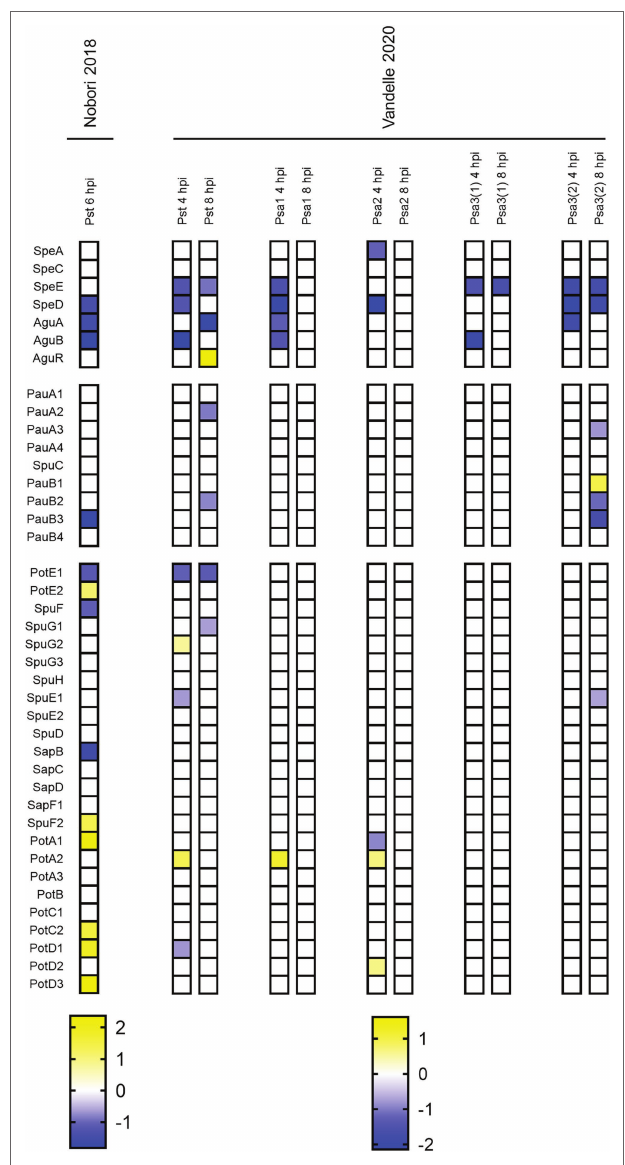
FIGURE 2 | Heatmap representing polyamine metabolism gene expression levels in P. syringae during growth in apoplastic-like conditions compared to rich media. Color scales represent expression levels reported by the authors of indicated references. Gene expression levels were considered if log 2 FC > |0.5| and p adj <